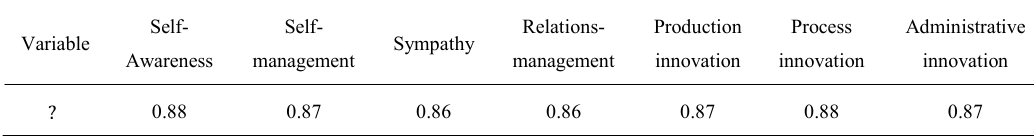
Table 2: Results of research structure ‘ s Cronbach-